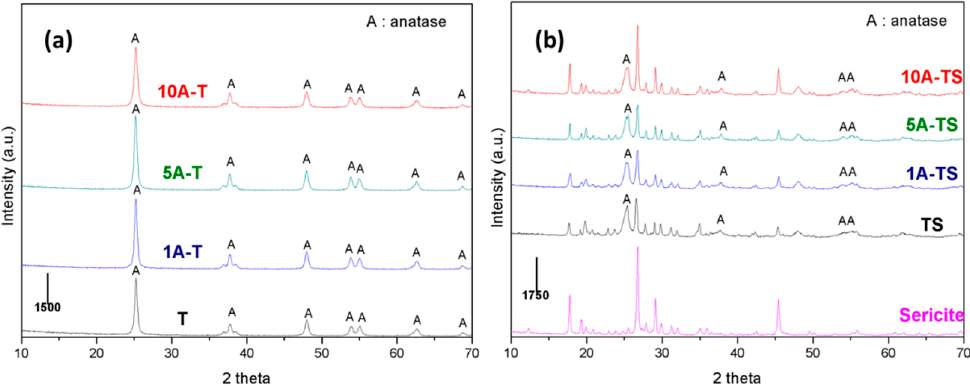
Figure 1. X-ray di ff raction spectra of ( a ) TiO 2 series photocatalysts and ( b ) TiO 2 / sericite series Figure 1. X-ray diffraction spectra of ( a ) TiO 2 series photocatalysts and ( b ) TiO 2 /sericite series photocatalysts with di ff erent amounts of acetic acid added during photocatalysts with different amounts of acetic acid added during preparation.